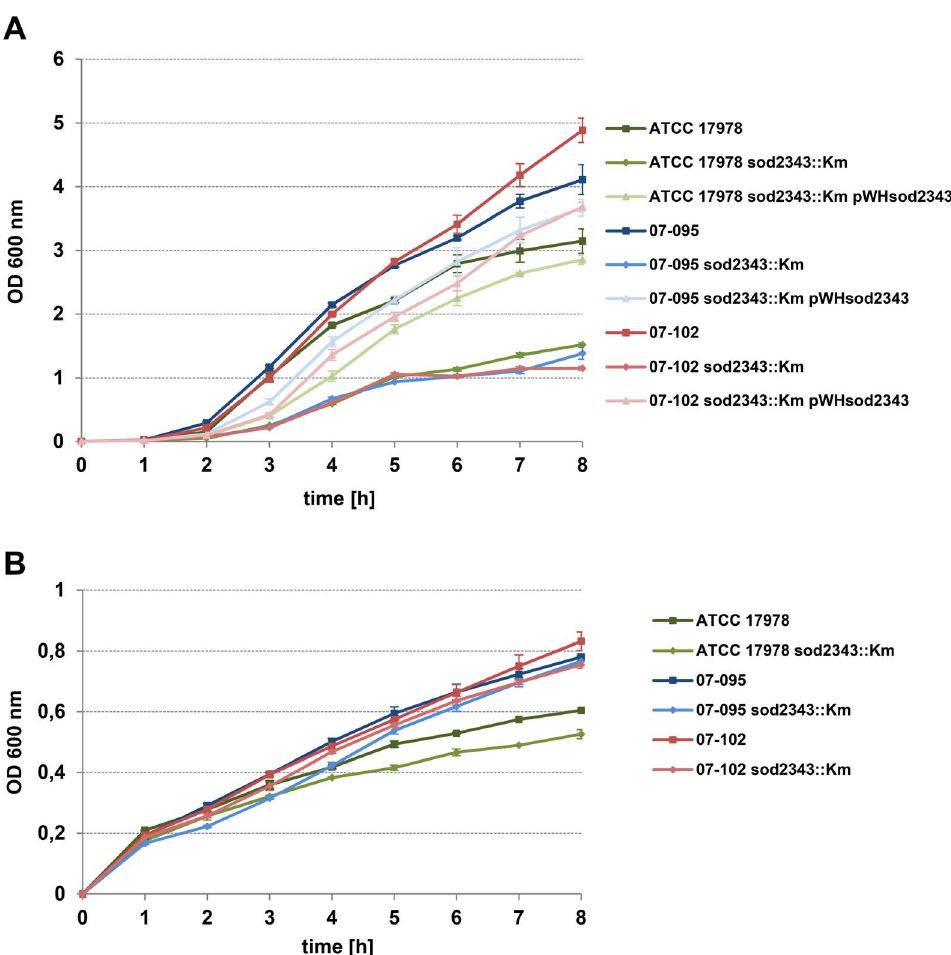
Figure. 4. Growth defects of sod2343 mutants depend on extent of aeration. Bacterial cultures as indicated were OD-adjusted from overnight cultures and grown at 37 u C in LB medium under constant shaking for 8 hours either in baffled flasks (A) or in tubes (B) and the OD (600 nm) was determined. For each strain, data obtained from three independent cultures were averaged; error bars represent plus/minus one standard deviation. Growth of all sod2343 mutants was significantly delayed compared to their parentals when grown in baffled flasks (A) (p , 0.005, Student’s t test,two-tailed, unpaired, for the last three time points). When grown in tubes (B), only the difference between ATCC 17978 and ATCC 17978 sod2343 was significant (p ,